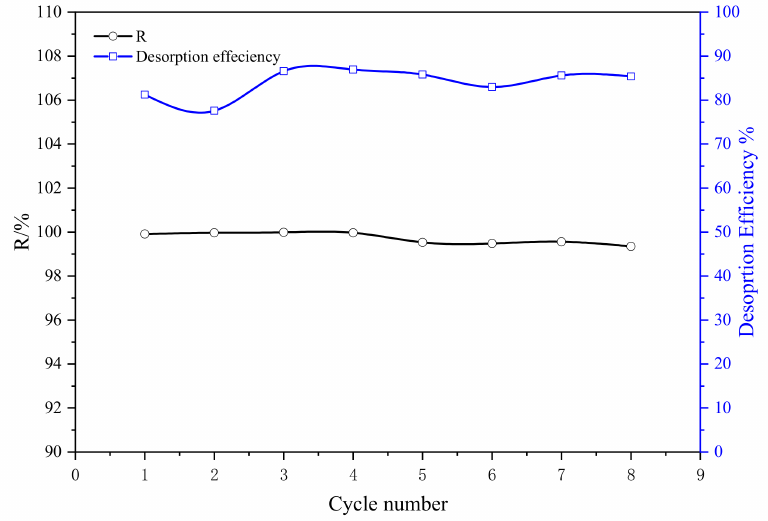
Figure 15. HCl desorption and reabsorption test results